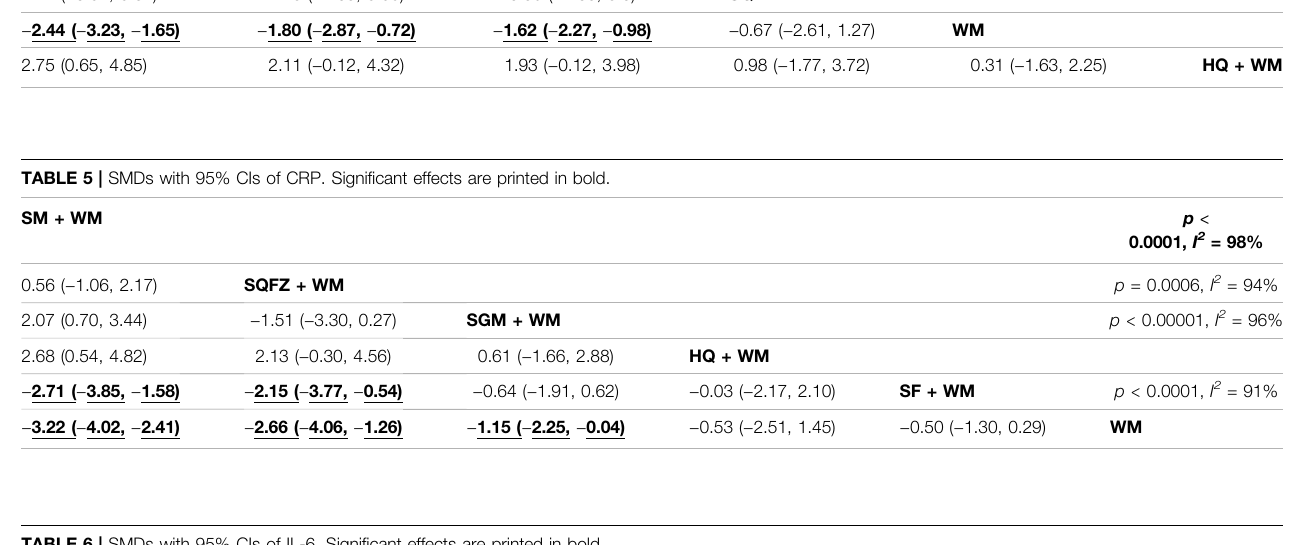
TABLE 6 | SMDs with 95% CIs of IL-6. Signi fi cant effects are printed in bold.